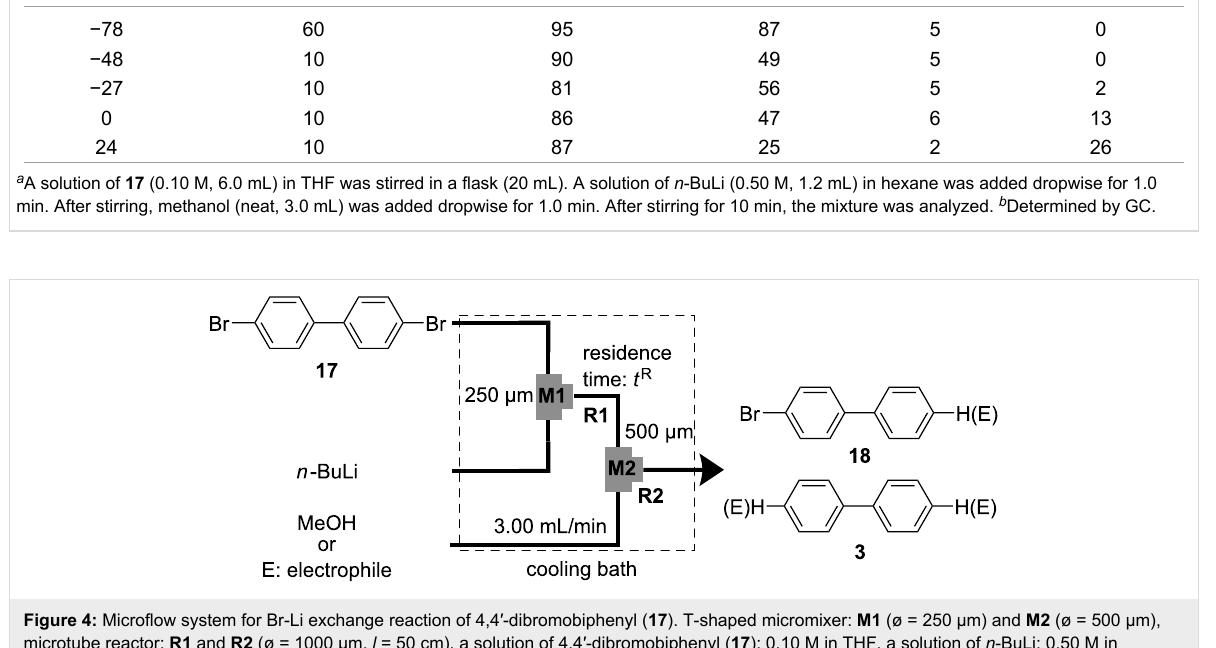
Table 5: Br-Li exchange reaction of 4,4′-dibromobiphenyl ( 17 ) using a conventional macrobatch system. a temperature (°C) reaction time (min)